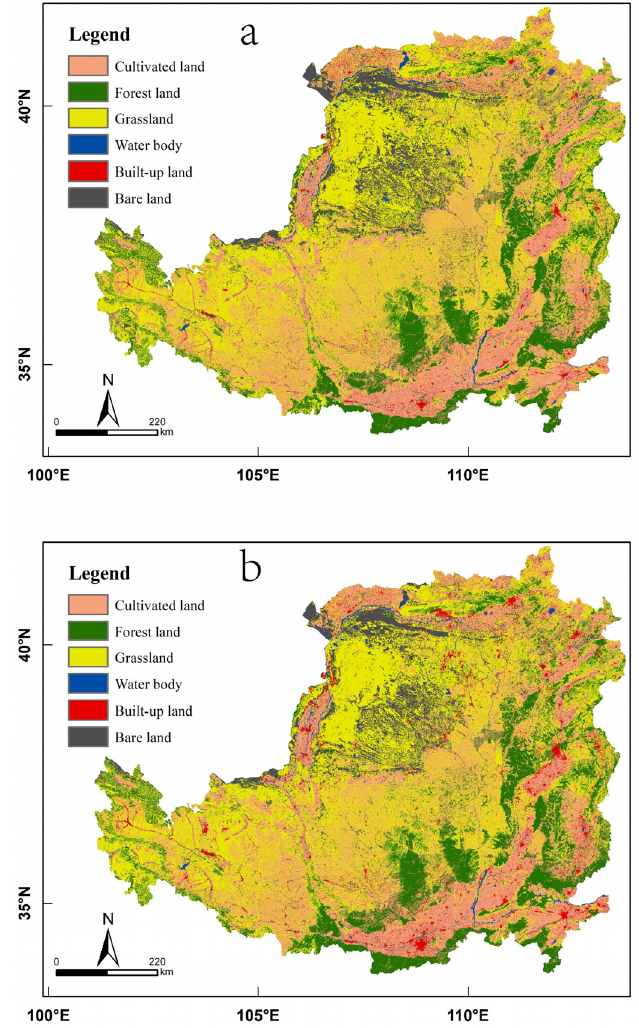
Figure 2. Land use map of the Loess Plateau in ( a ) 2000 and ( b ) 2018. The grassland area decreased from 258,855.74 km 2 in 2000 to 256,568.11 km 2 in 2018, with a total decrease of 2287.63 km 2 in 18 years and an average annual change rate of 0.05% (Table 1). According to the results of the transfer matrix, in terms of the number of transfers (Figure 3b), grassland was mainly transferred to cultivated land, forest land and built-up land, with the transferred area accounting for 35.67%, 34.70% and 17.21% of the total transferred area, respectively. In terms of the spatial distribution of the transfers (Figure 3a), the transformation of grassland into cultivated land was mainly concentrated in the irrigated agricultural region and the northern part of the loess sorghum gully region; the transformation of grassland into forest land was mainly concentrated in the eastern part of the sand and desert region, the southern part of the loess hilly gully region and the northern and southern part of the loess sorghum gully region; and the transformation